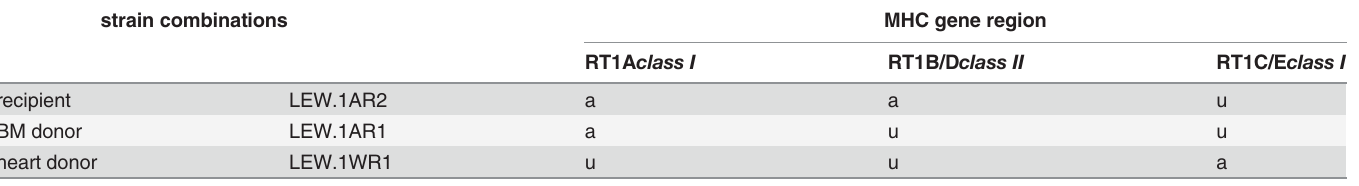
Table 1. MHC (RT1) immunogenetics of strain combinations used for heart transplantation to BMT recipients. strain